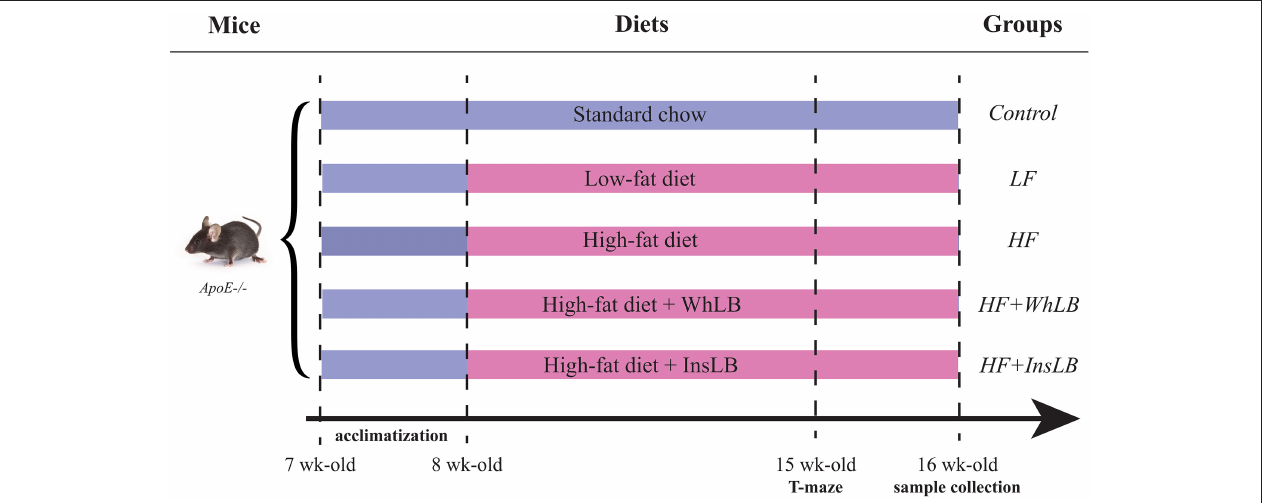
FIGURE 1 | Schematic representation of the experiment. Male ApoE–/– mice were acquired at the age of 7 weeks and left to adapt to the environment and diets for a week. Animals were fed with the different diets for 8 weeks: a standard chow, a low-fat diet, and a high-fat diet (either alone or with whole lingonberries and their insoluble fraction) before perfusion and sample collection.